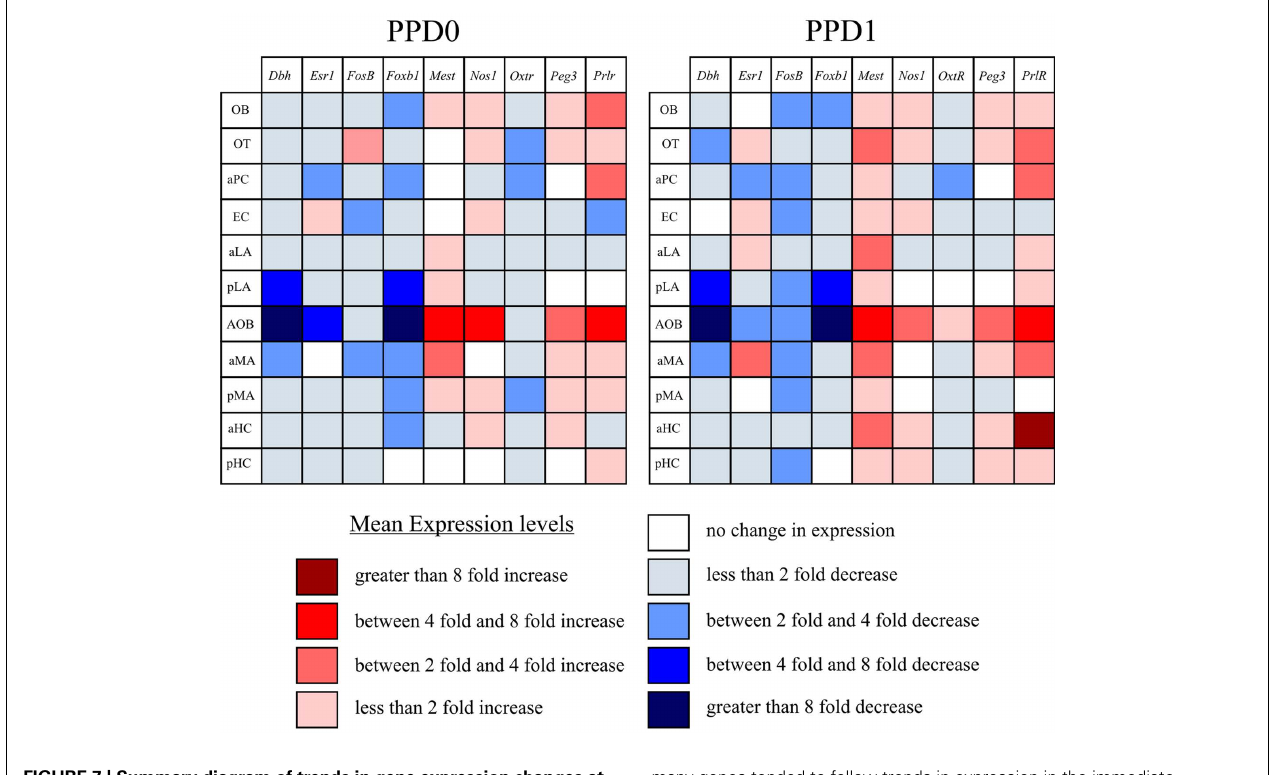
FIGURE 7 | Summary diagram of trends in gene expression changes at PPD0 and PPD1. Using mean fold expression, we plotted changes in expression in a matrix of region vs. gene.This matrix highlights that the largest magnitude changes (both increase and decrease in expression) were found in the accessory olfactory pathway (i.e., AOB and aMA). It also highlights that